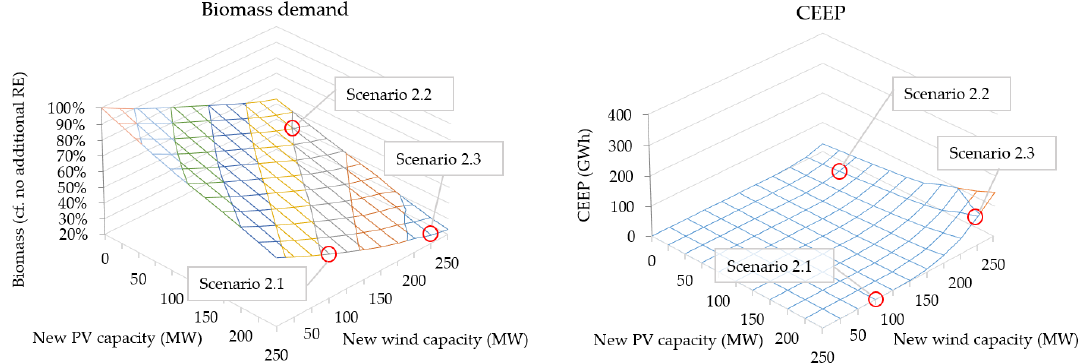
Figure 4. Sensitivity study for a smart energy system, including proposed scenarios—resulting in additional biomass demand and CEEP.